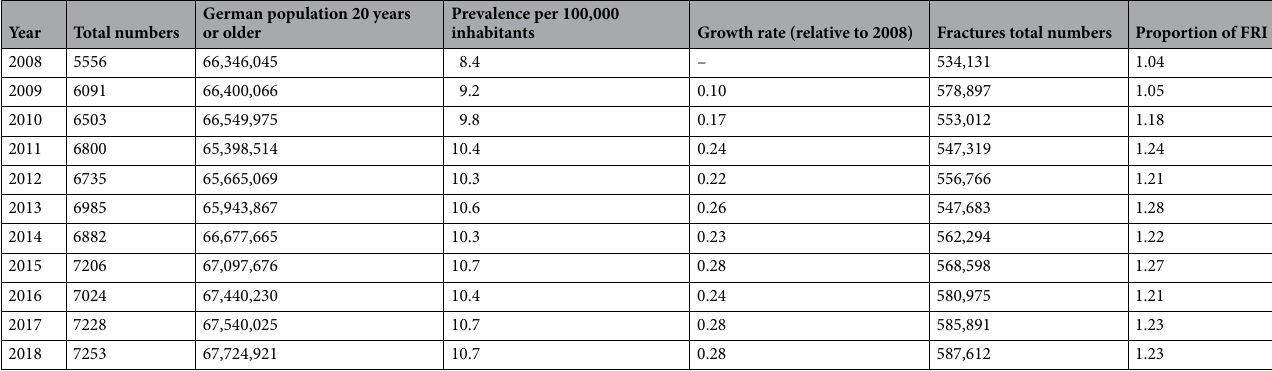
Table 2. Historic development of population and fracture-related infection prevalence from 2008 through 2018.